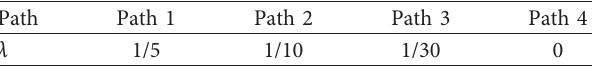
Table 3: The different saturation λ . Table 2: The shape parameters of each obstacle.